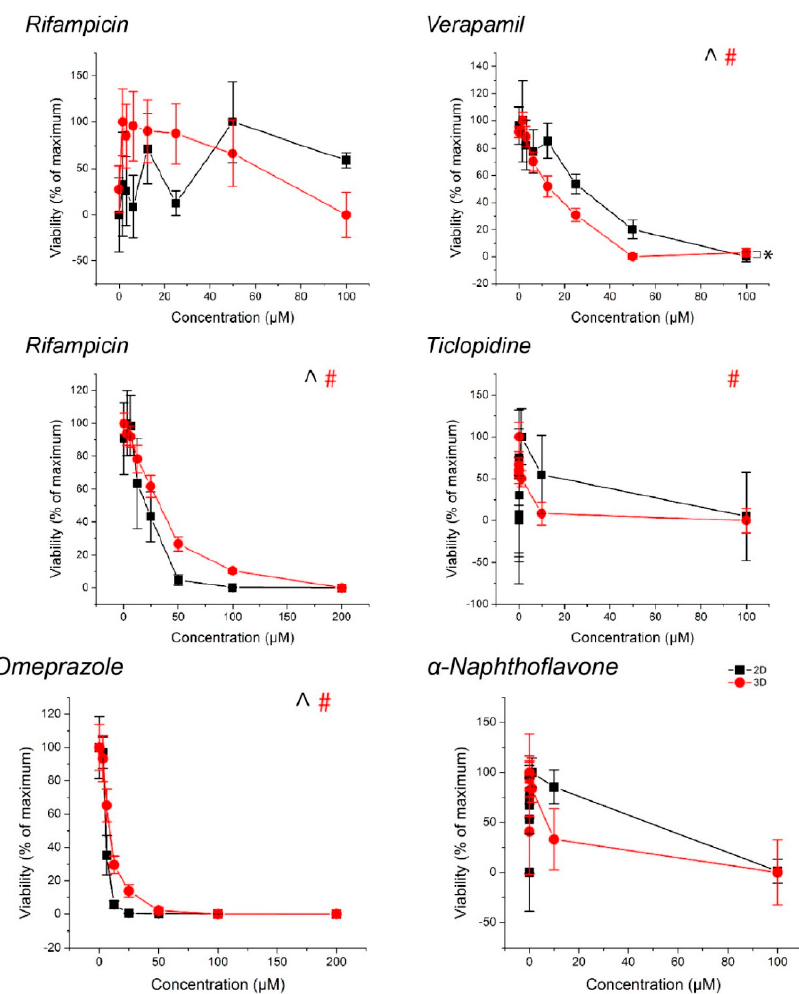
Figure 5. Viability of hepatocyte spheroids and monolayers, normalized to control. ^, #: p < 0.05 effect of concentration on viability. *: p < 0.05 difference in viability between 2D and 3D. Error bars represent standard error.